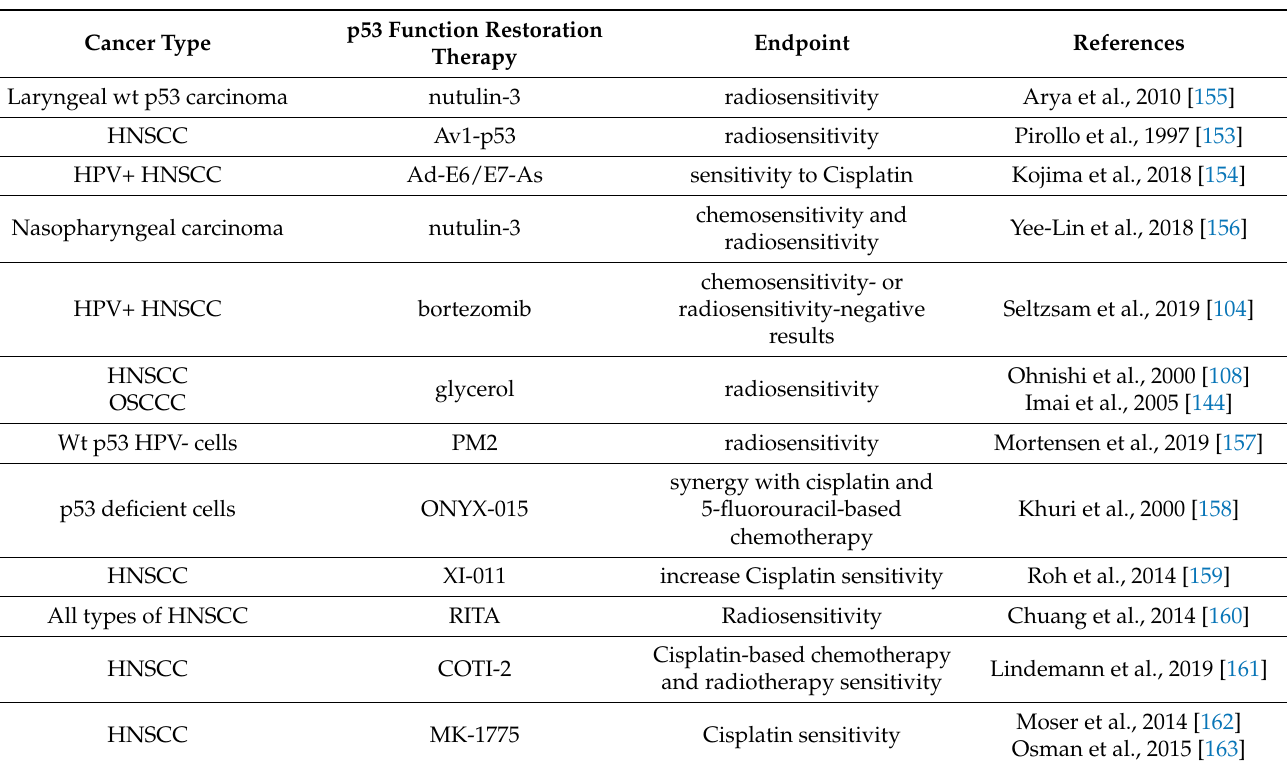
Table 3. p53 restoration-based therapy for radiotherapy and chemotherapy sensitivity modulation in HNSCC.